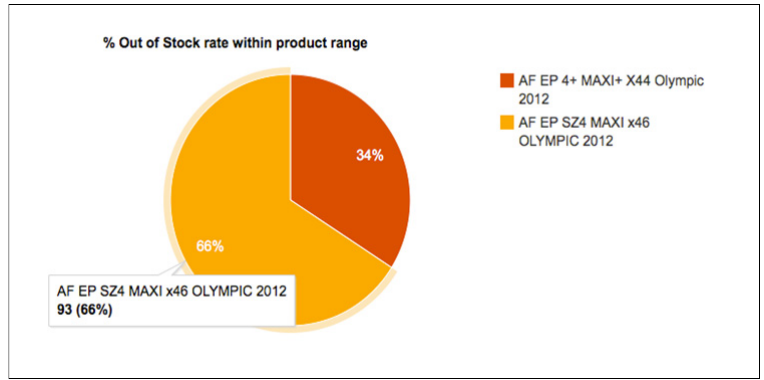
Figure 6. Shelf-out-of-stock by SKU.